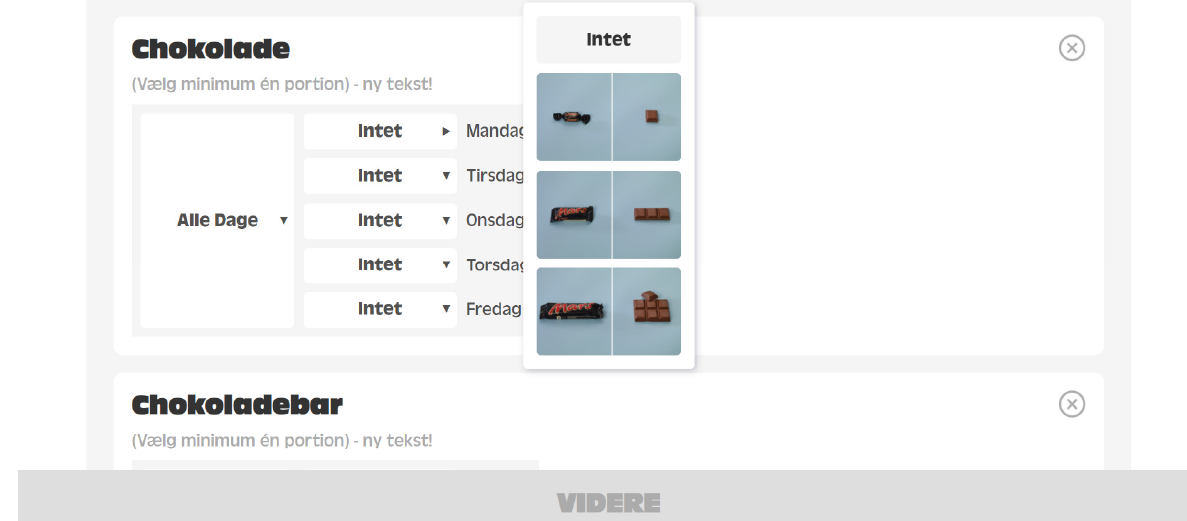
Figure A1. Screen shot from the SRFS. Website where parents registered which discretionary foods and drinks their child had eaten at specific occasions. On this picture is “Candy and chocolate” and “Sweet drinks”.